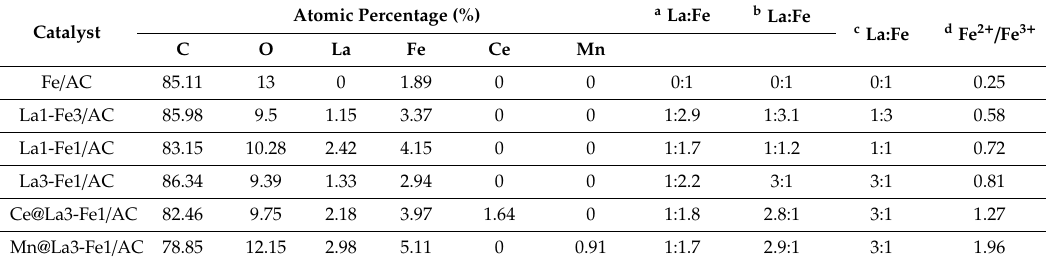
Figure 3. XPS survey spectrum of the synthesized catalysts. Table 1. Surface composition of the synthesized